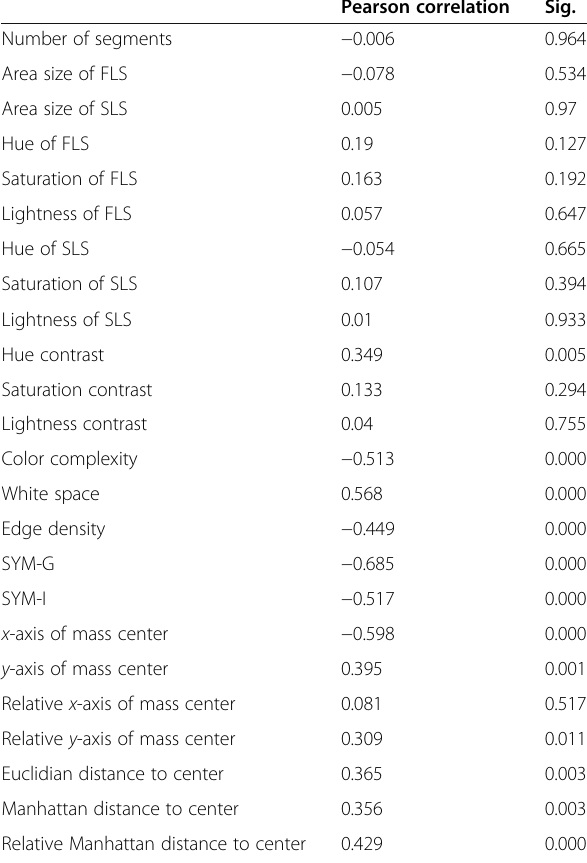
Table 3 Correlation between the rating of visual order and computed features